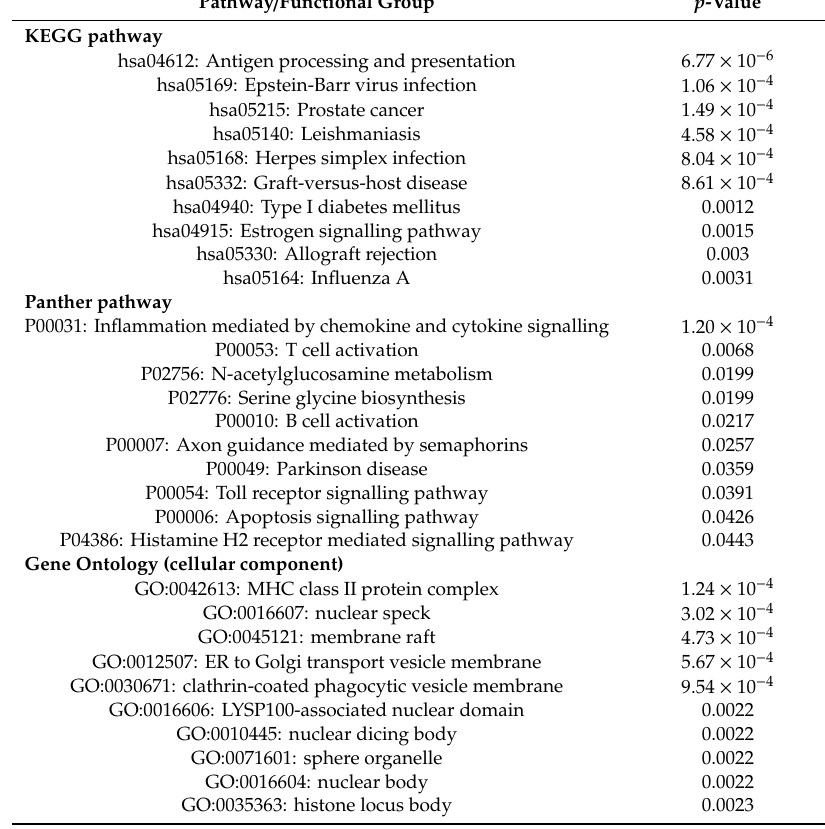
Table 4. Enrich R analysis of PVL versus control non-lesional white matter transcriptomic datasets. The top 10 pathways / functional groups identified by the analysis are shown